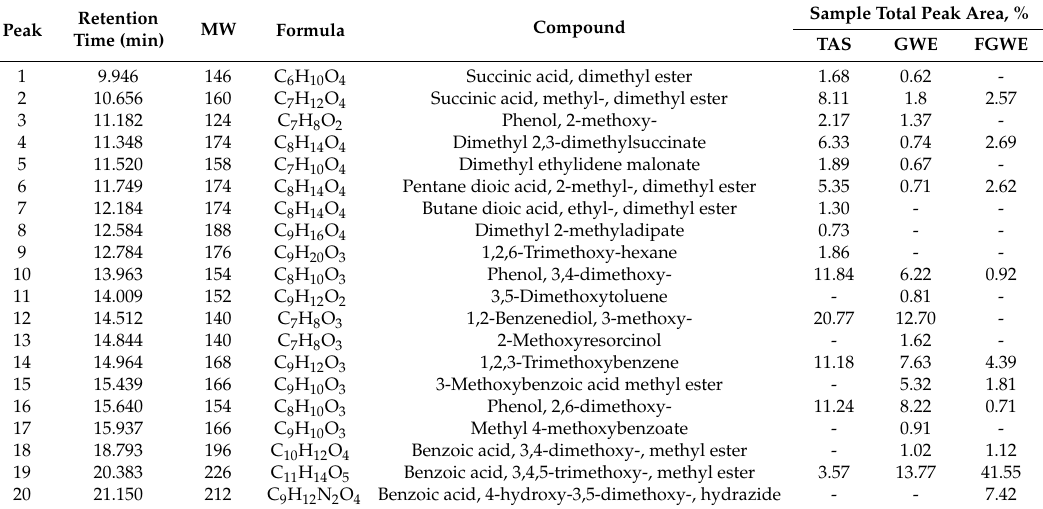
Note: “-” indicates a compound peak area of <0.6% in the table.